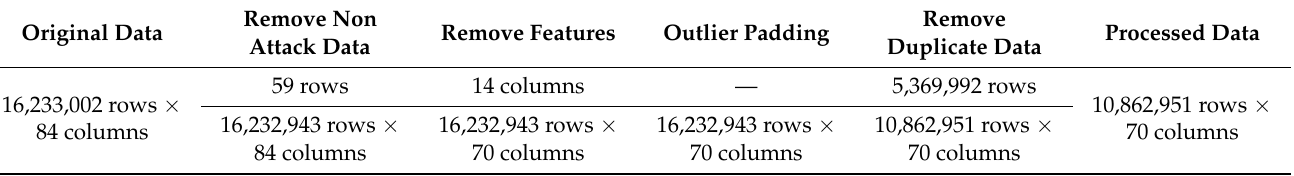
Table 3. Original data, deleted non-attack data and data after